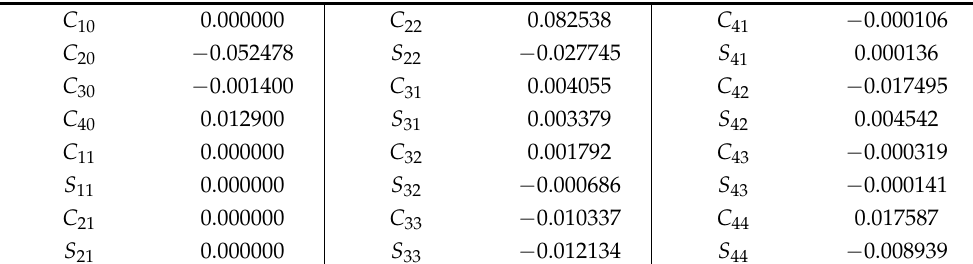
Table 1. Gravity harmonic coefficients of